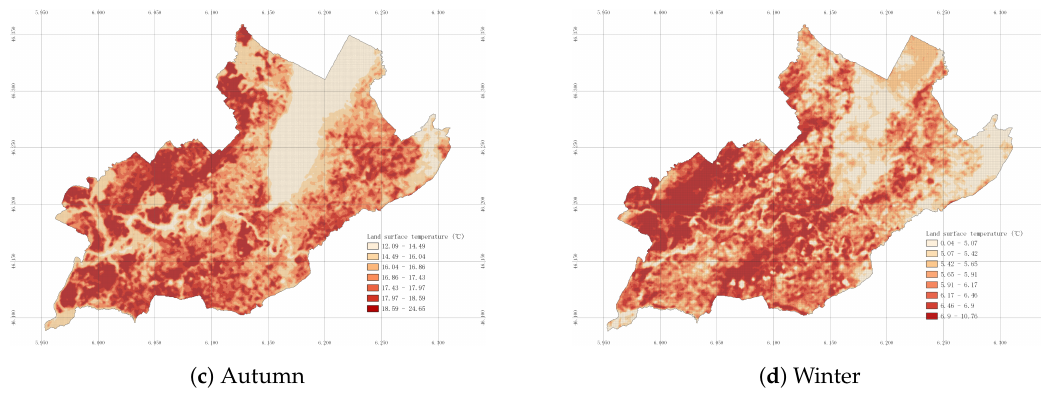
Figure 6. Mean Land Surface Temperature ( ◦ C) of four seasons in Geneva.